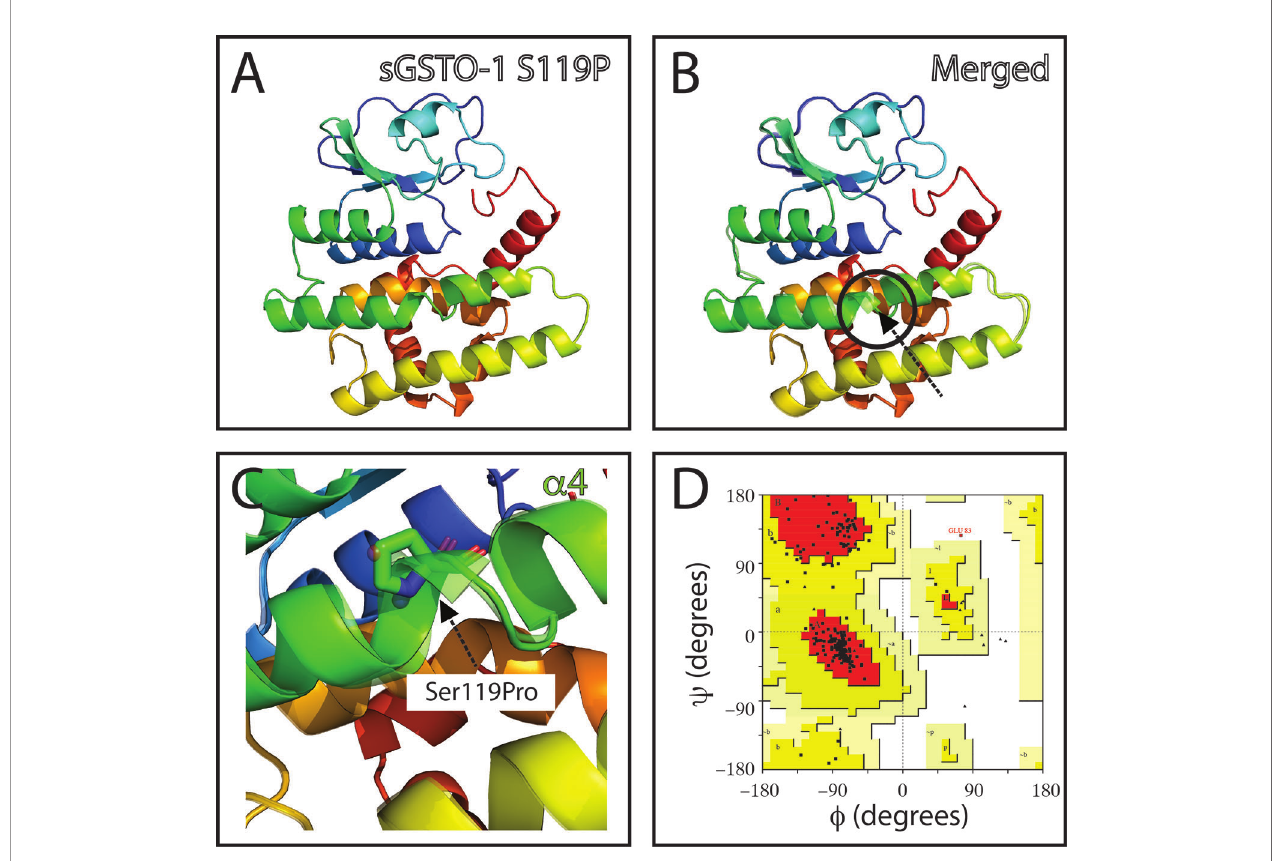
FIGURE 3 | Evaluation of single-nucleotide polymorphism (SNP) c.484T > C effect on the predicted S. salar GSTO-1 (sGSTO-1) structure by homology modeling. (A) Predicted tridimensional sGSTO-1 including the S119P substitution (sGSTO-1 S119P). (B) sGSTO-1 and sGSTO-1 S119P overlay. The punctual amino acid substitution (dotted arrow line) and the structural region ( a 4 helix kink, circle) are indicated. (C) Enlarged view of the sGSTO-1 S119P substitution shown in (B) . sGSTO-1 (transparent) and sGSTO-1 (colored) are shown. (D) Ramachandran plot for the predicted sGSTO-1 S119P structure. The amino acid distribution into most favored regions (A,B,L), additional allowed regions (a,b,l,p), generously allowed regions (~a,~b,~l,~p), and disallowed regions (GLU83) is